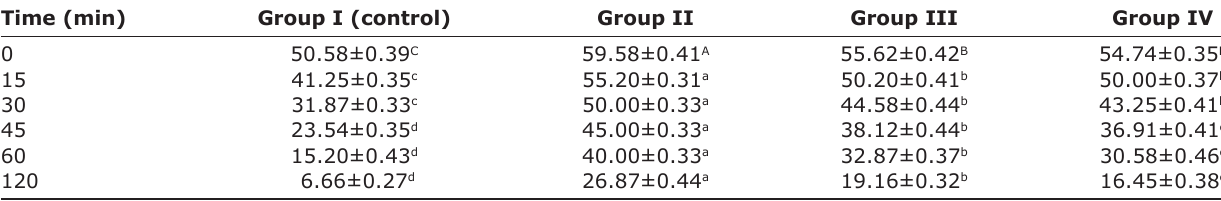
Table-3: Mean±SE of effect of incubation on post-thaw motility at various post-thaw incubation periods. Time